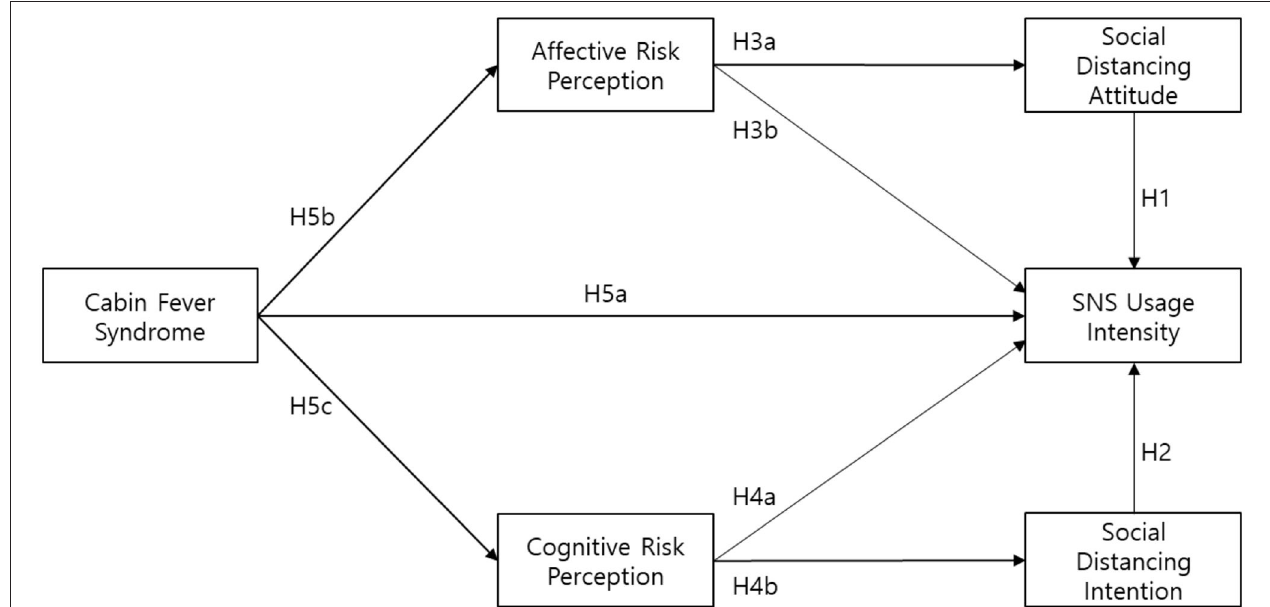
FIGURE 1 | Research